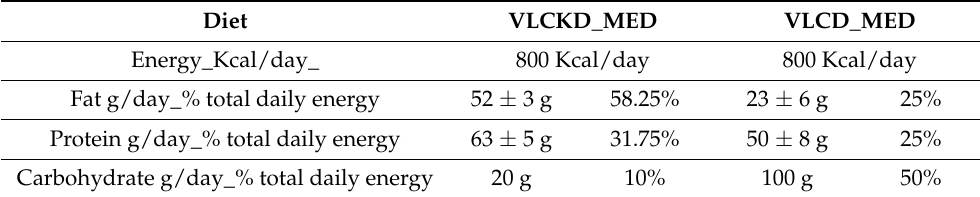
Table 3. VLCKD_MED and VLCD_MED